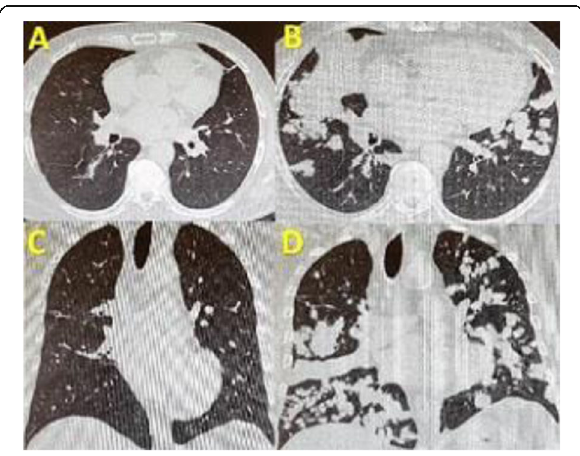
Fig. 1 (abstract P137). Tomography of the chest. Solid, confluent and poorly defined nodules and masses, some with permeating air bronchograms, distributed diffusely across both lung fields ( b and d ), absent in a previous study ( a and c